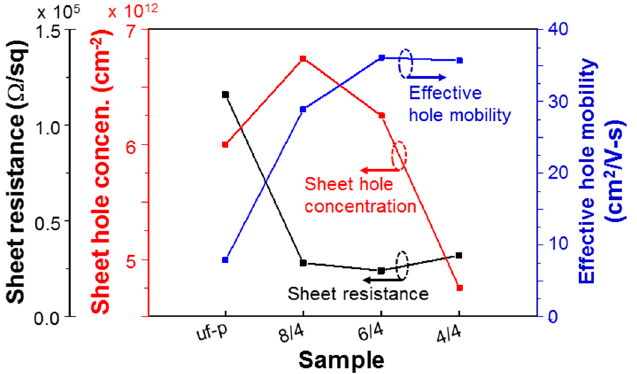
Figure 10. Variations of sheet resistance (with the first left ordinate), sheet hole concentration (with the second left ordinate), and effective hole mobility (with the right ordinate) of samples uf-p, 8/4, 6/4, and 4/4.